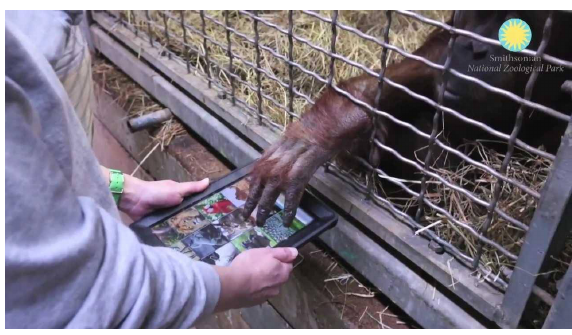
Figure 8. Apps for Apes: An orangutan using a touchscreen [101].